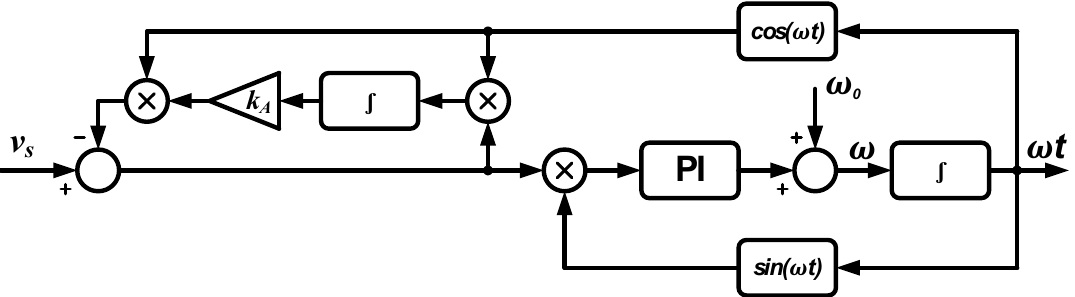
Figure 10. Enhanced phase-locked loop (EPLL) proposed by Karimi-Ghartemani et al. (based on [43]).